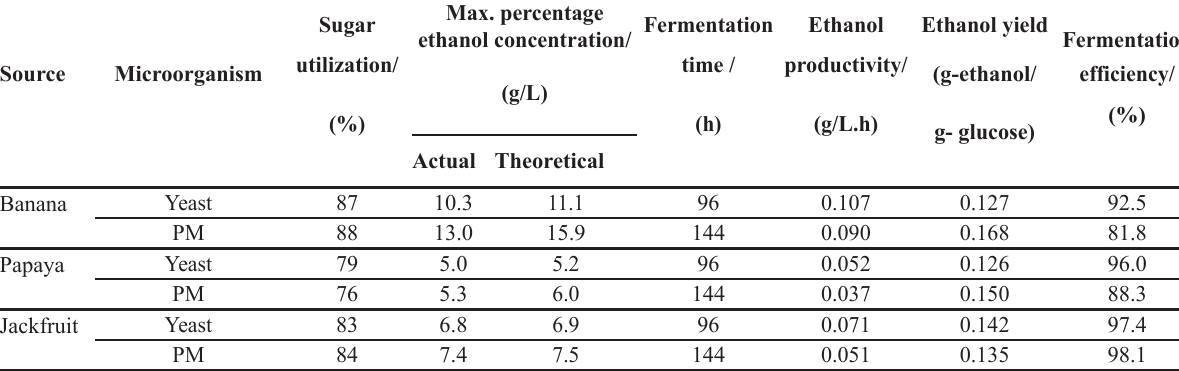
Table 4: Fermentation and bioethanol production